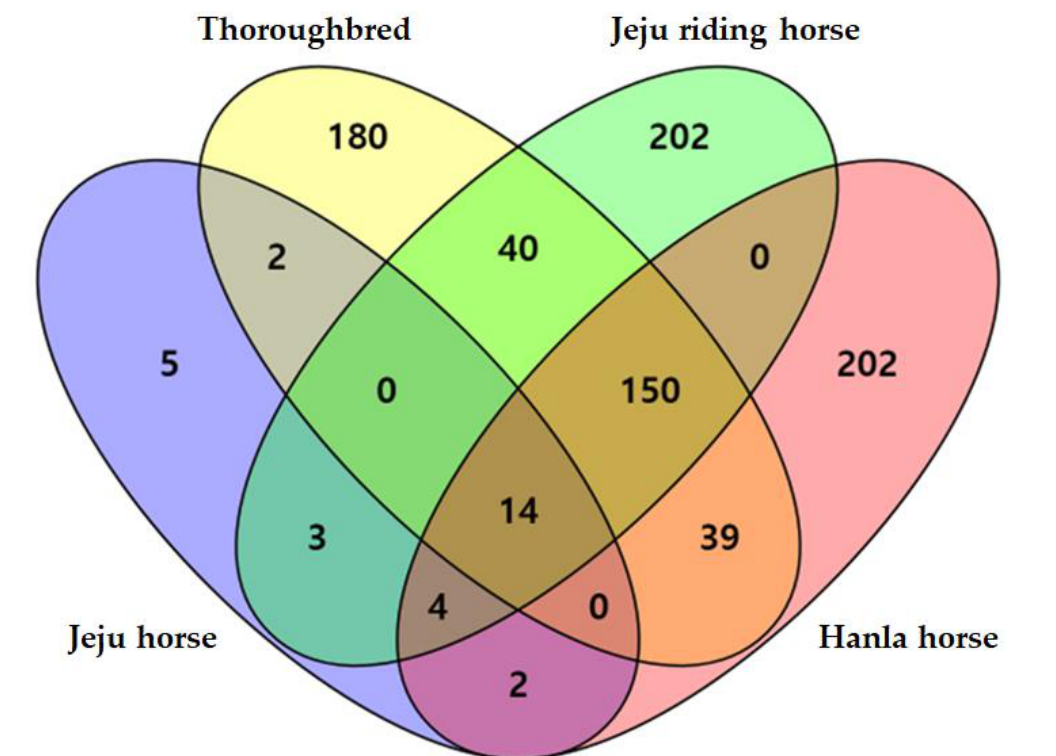
Figure 3. Number of overlapping copy number variation regions (CNVRs) between four breeds in South Korea. Purple is number of Jeju horse CNVR; Yellow is number of Thoroughbred CNVR; Green is number of Jeju riding horse CNVR; Red is number of Hanla horse CNVR, respectively